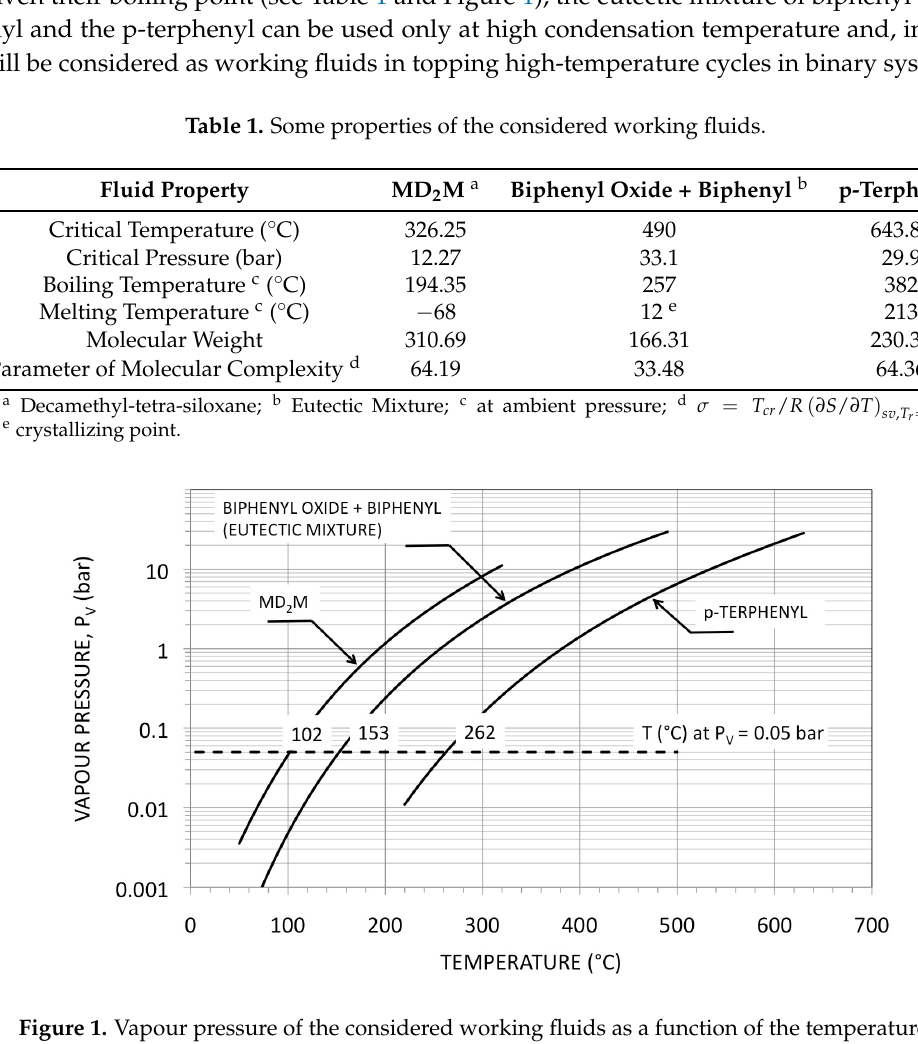
Figure 1. Vapour pressure of the considered working fluids as a function of the